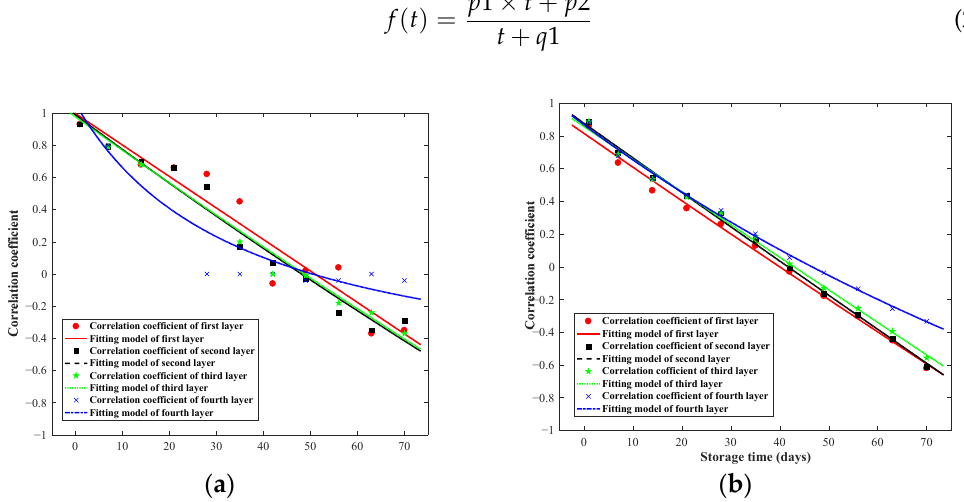
Figure 4. The model of the grain temperature correlation coefficient threshold in the XOY planes: ( a ) fitting model of clustering results with DBSCAN; ( b ) fitting model of clustering results with 3 σ .